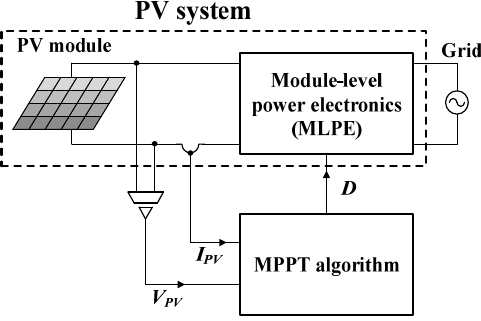
Figure 5. Diagram of the distributed photovoltaic (PV) system with maximum power point tracking (MPPT) algorithm.